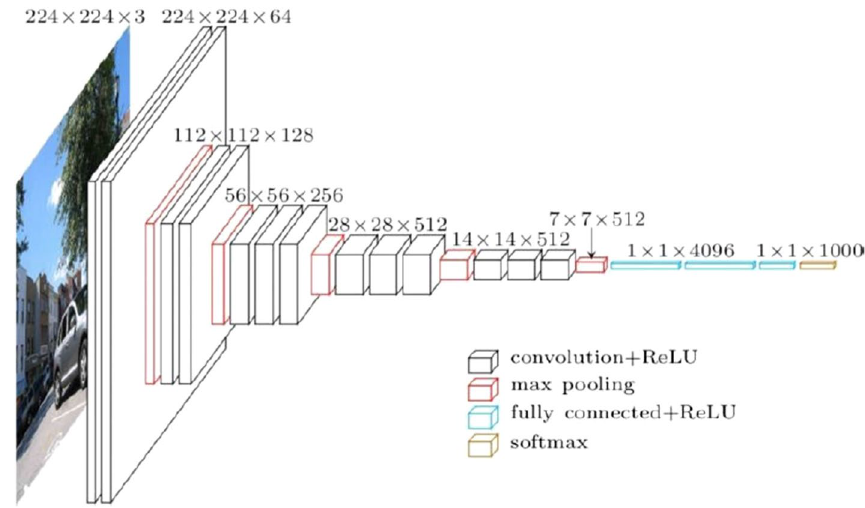
Fig. 4 The architecture of VGG-16 ConvNet